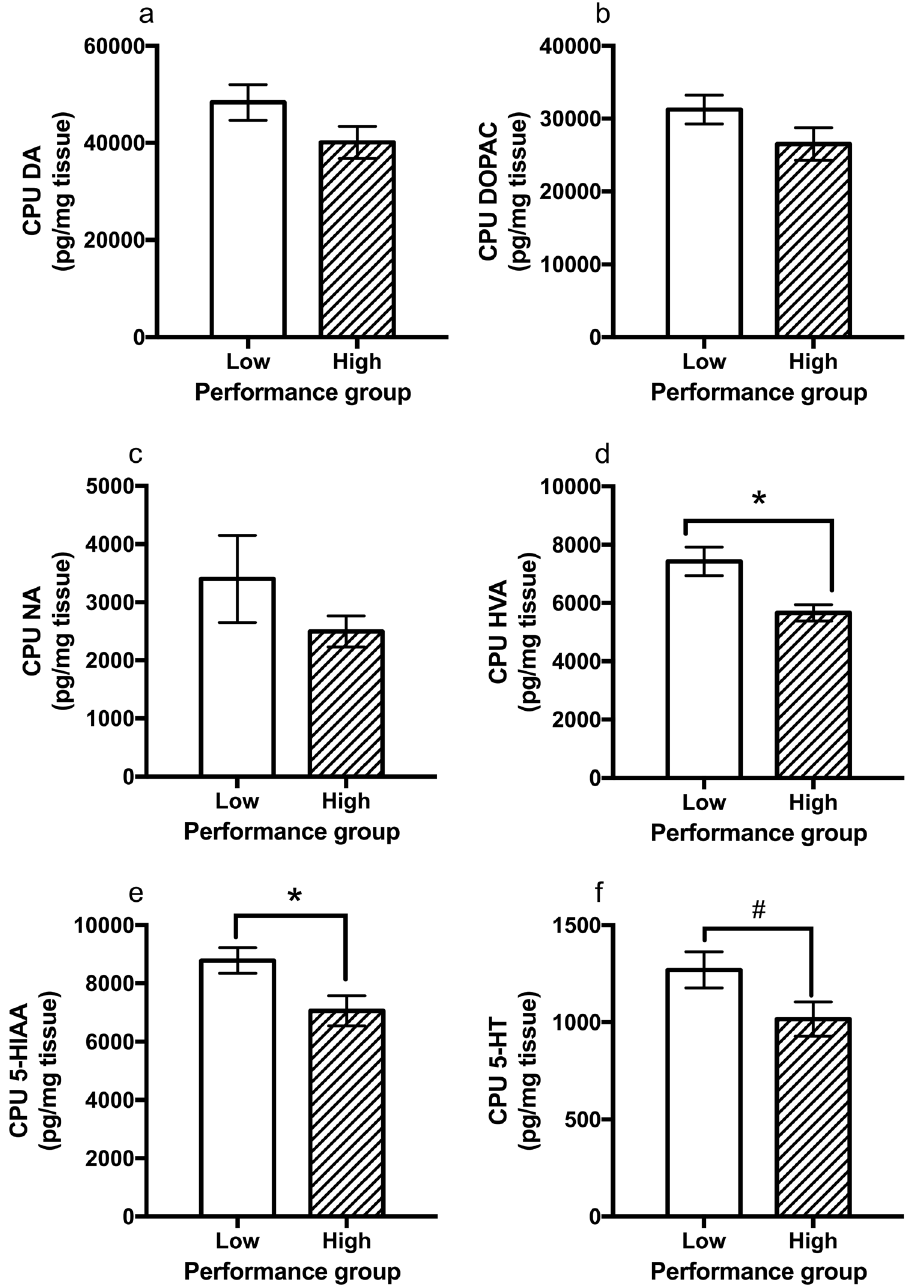
Figure 4. Catecholamine levels in the striatum (CPU) of low and high performing rats. Performance groups did not significantly differ in ( a ) dopamine (DA), ( b ) dihydroxyphenyl acetic acid (DOPAC) or ( c ) noradrenaline (NA). However, low performing rats had significantly more ( d ) homovanillic acid (HVA) and ( e ) 5-hydroxyindoleacetic acid (5-HIAA) than high performing rats with ( f ) serotonin (5-HT) showing a non- significant trend in the same direction. # p = 0.065, * p <